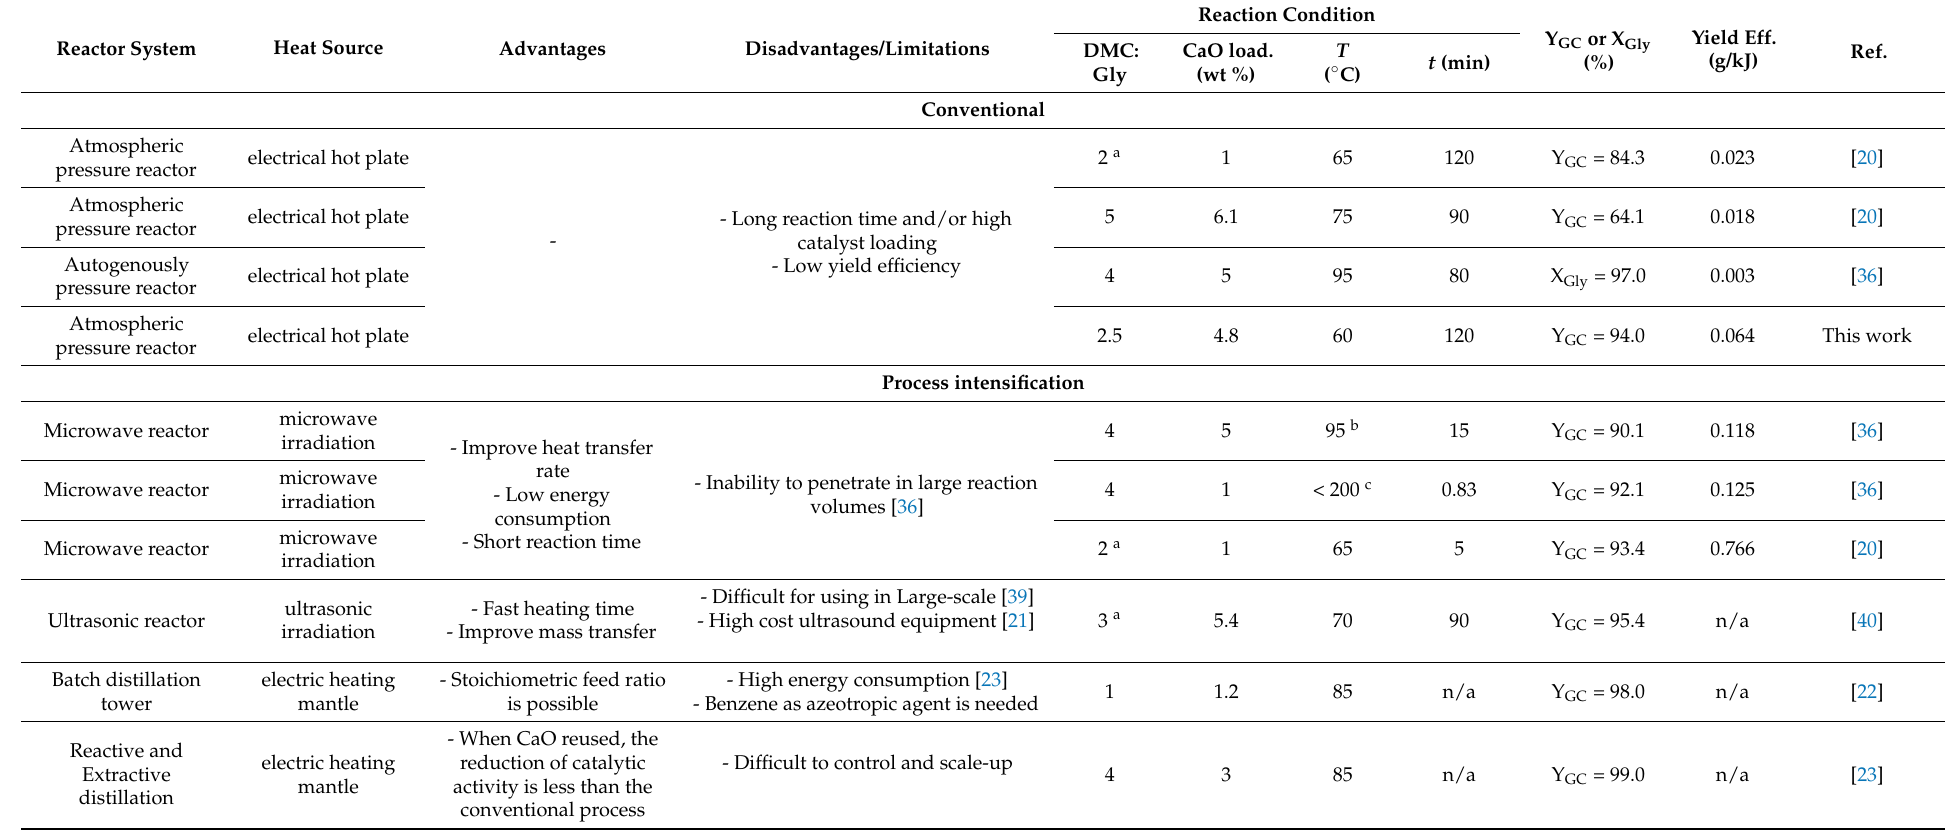
Table 1. Comparison of kitchen countertop blender with other process intensifications and conventional